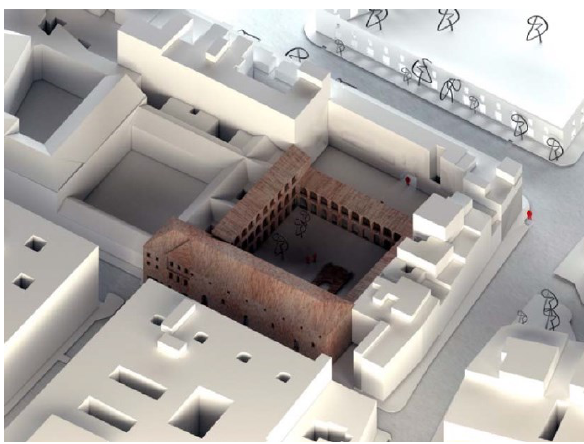
Figure 8. Volumetry of the convent's pre-existence in their